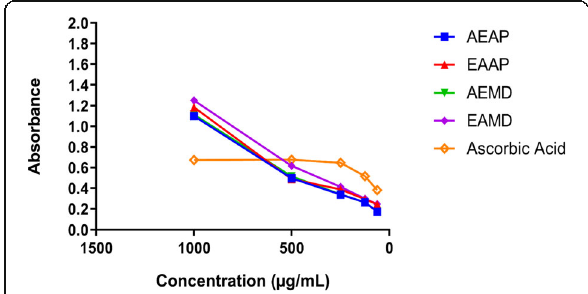
Fig. 2 Reducing power activity of the extracts. The values are presented as mean ± SD, ( n = 3)